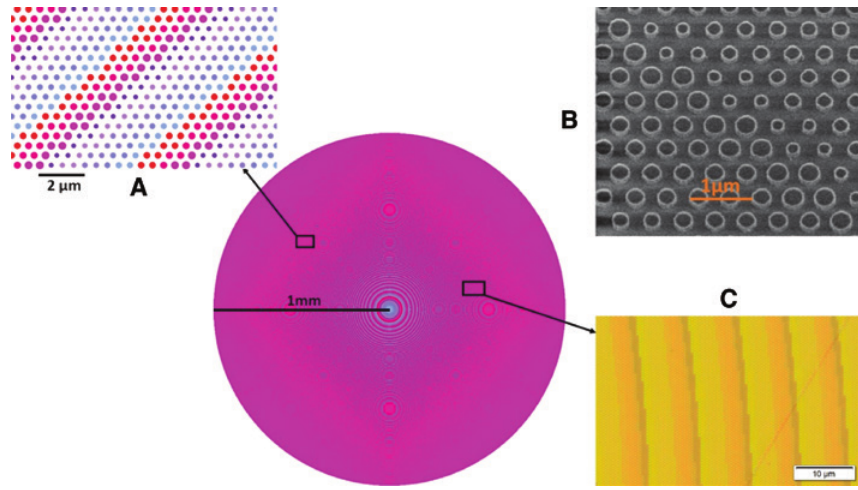
Figure 3: Metalens design pattern for e-beam lithography. Each color represents a different antenna radius. The bulls-eye pattern in the center of the metalens are the Fresnel zones. Other bulls-eye patterns are aliasing artifacts. Insets: (A) Zoom-in on antenna pattern. (B) SEM image of metalens section. (C) Optical microscope image of metalens section.